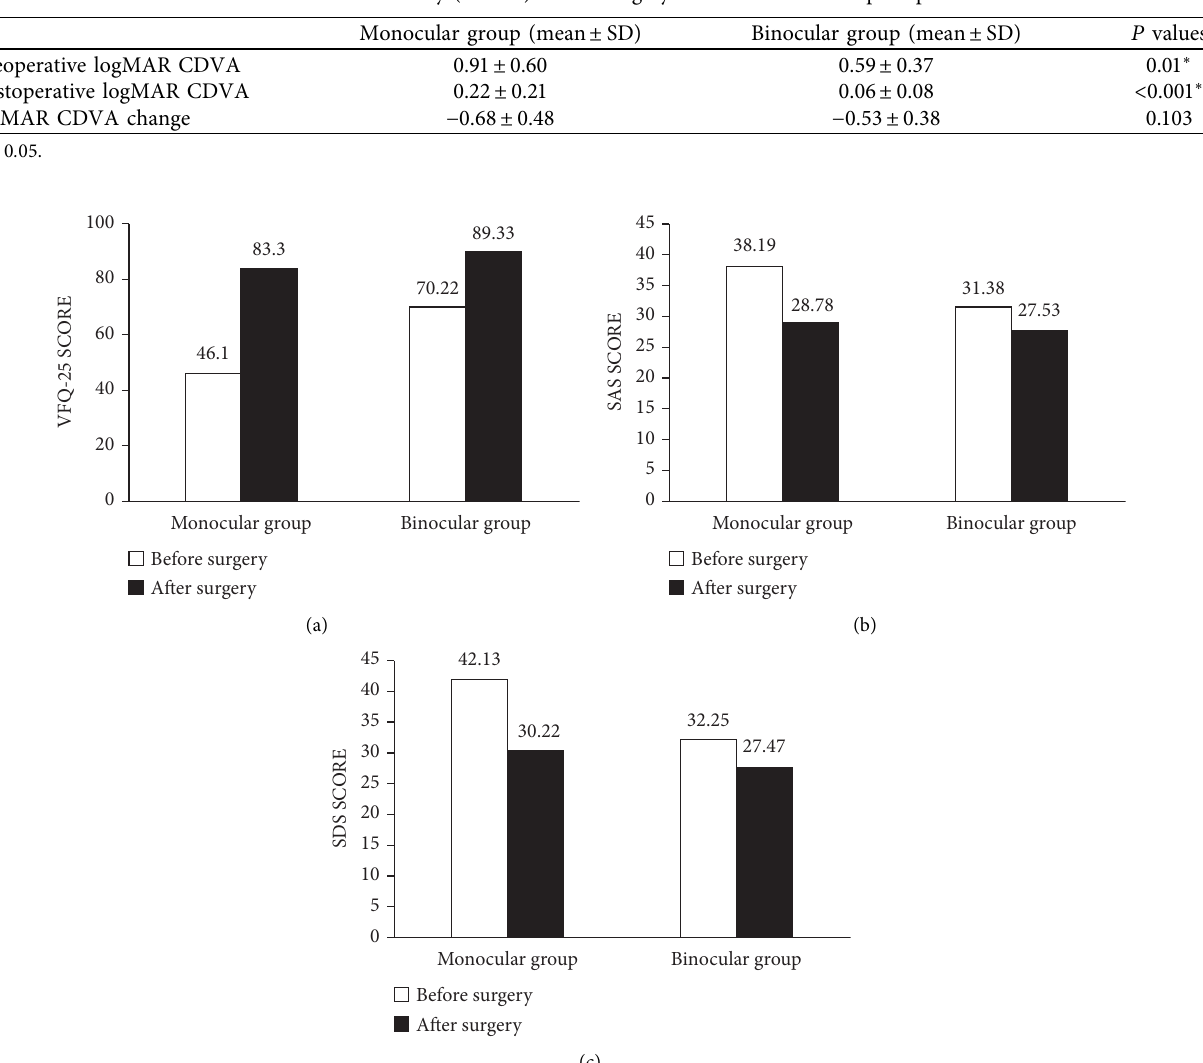
Table 2: Corrected distance visual acuity (CDVA) before surgery and at the 1-month postoperative